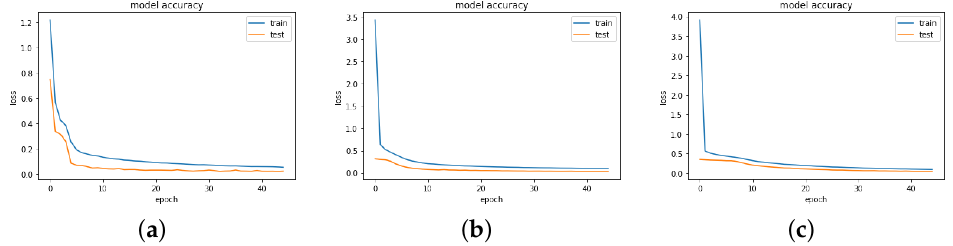
Figure 4. Train/Test LOSS values for Models A1, A2 and A3; ( a ) LOSS—Model A1; ( b ) LOSS— Model A2; ( c ) MAE—Model A3.